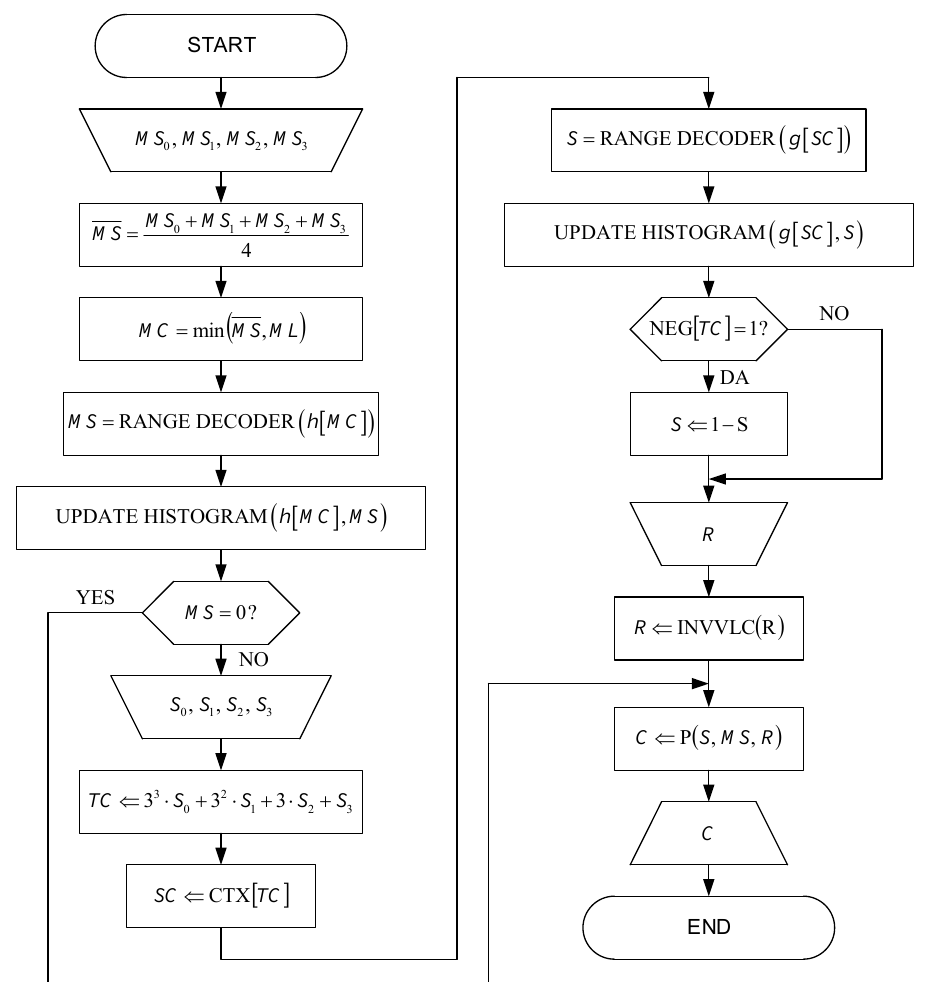
Figure 3. The flowchart of the entropy decoder and the decoding probability